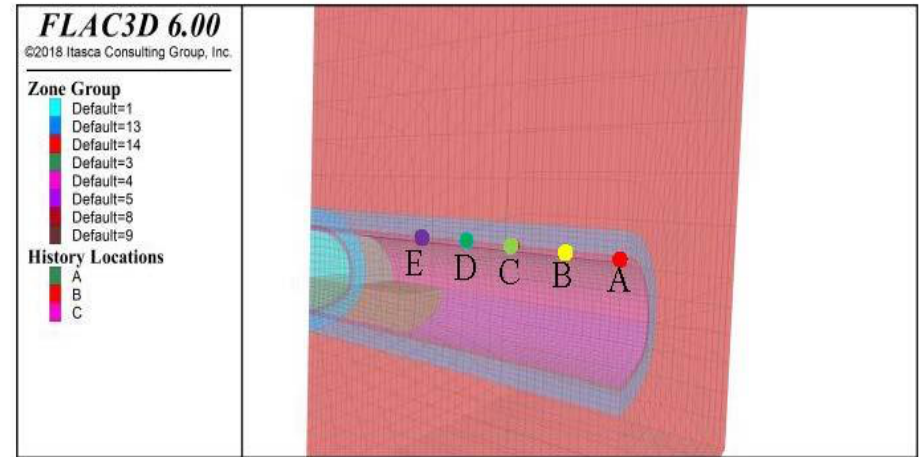
Figure 7. Sketch map for layout of analytical measuring points. (The distance between monitoring points is 6 m, and point a is located at the model boundary.)